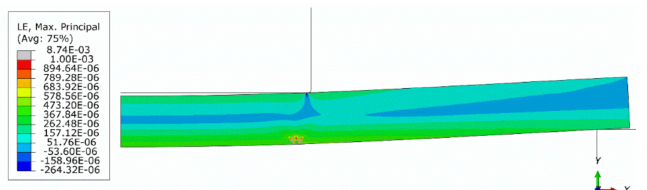
Figure 15. Contour plot of the maximum principal logarithmic measure of strain (axisymmetric model, global mesh size: 0.5 mm); deformed configuration; displacements scaled 10 times.